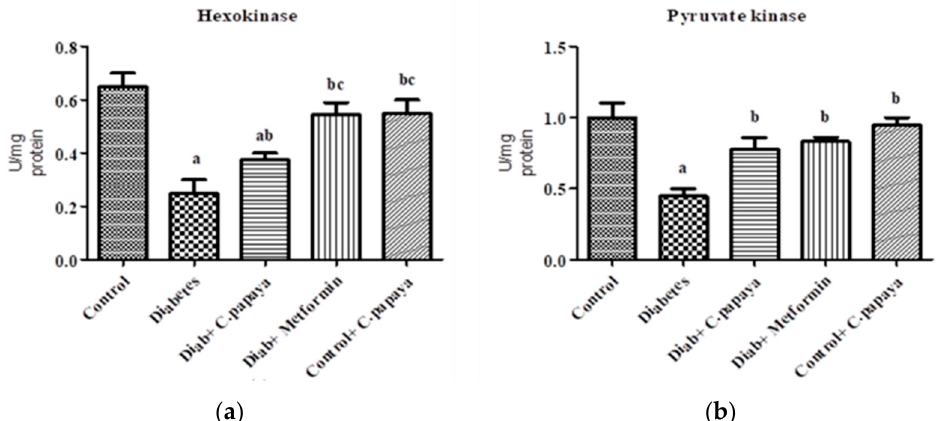
Figure 2. Outcome of ethanolic extract of C. papaya on ( a ) hexokinase and ( b ) pyruvate kinase levels in control and diabetic rats. Each bar illustrates the mean ± SEM of eight rats, with p < 0.05 demonstrating significant differences between the groups: a—control; b—diabetes; c—diabetic rats administered with ethanolic extract of C. papaya .